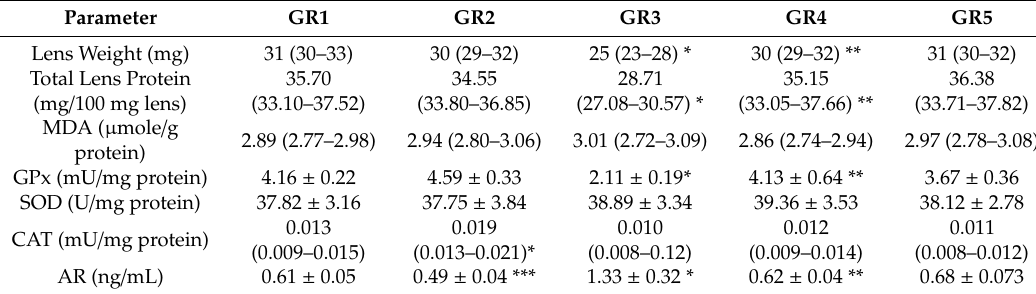
Table 4. Results of the lens enzymatic